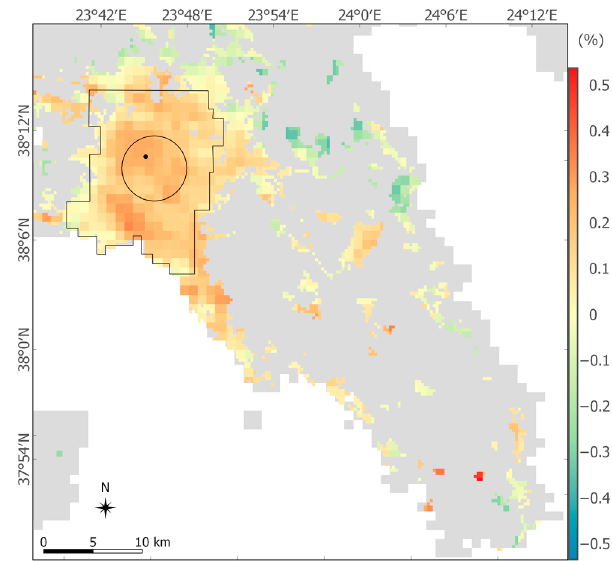
Figure 3. Daytime Land Surface Temperature (LST) trends of the urban pixels of Athens. The solid line indicates the boundary of the urban district, the circle indicates the urban core of the city and the point indicates the pixel selected for time series analysis. (gray: outside study area and non-urban pixels, white: sea).